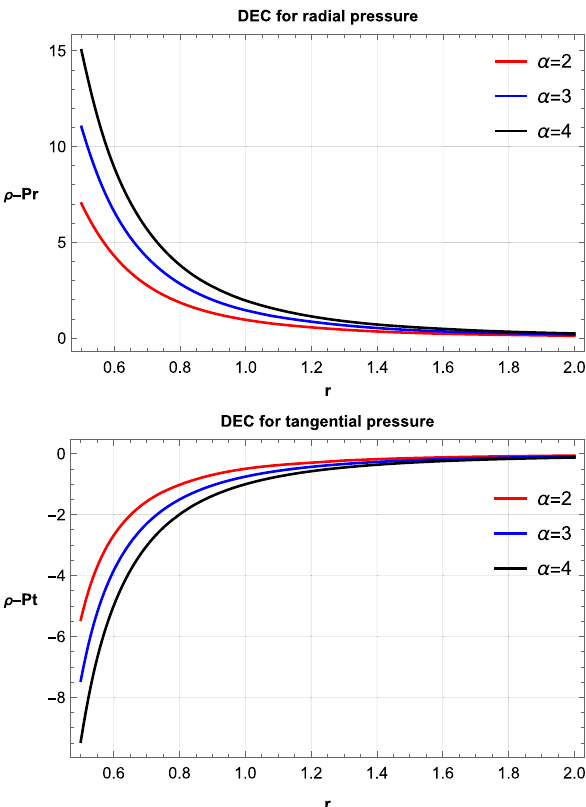
Fig. 7 The variation of NEC against r for parallel cylinder with r 0 = 0 . 5